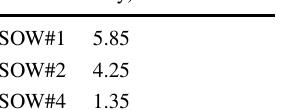
water in each shale oil well in MMSCF/Day during